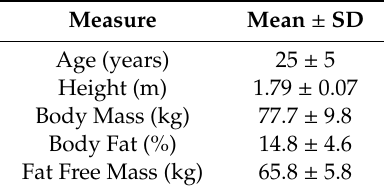
Table 1. Participant demographic